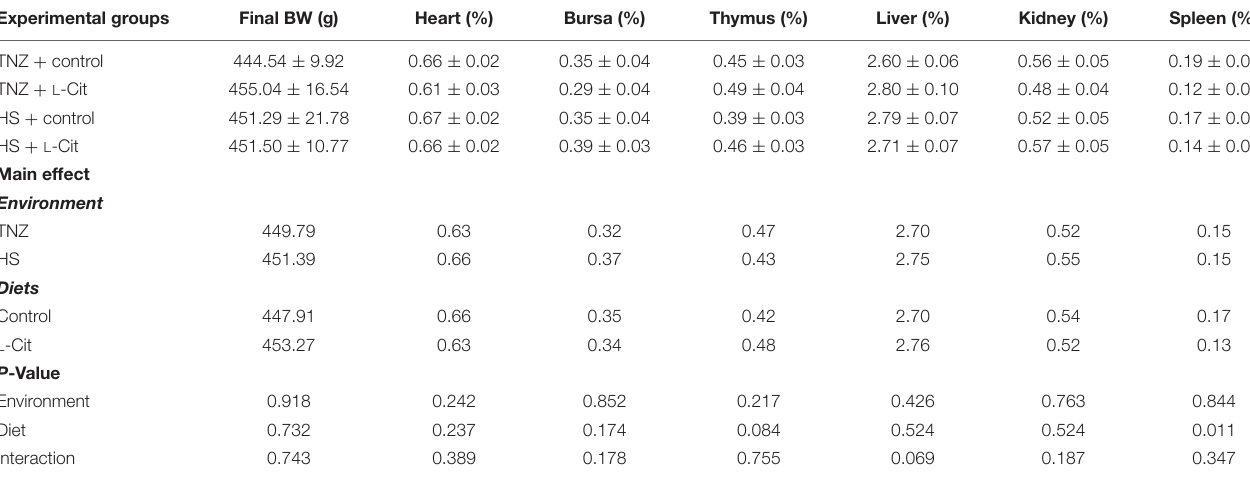
TABLE 3 | Effect of heat stress and L -citrulline supplementation on organ index of broiler chicken. Experimental groups